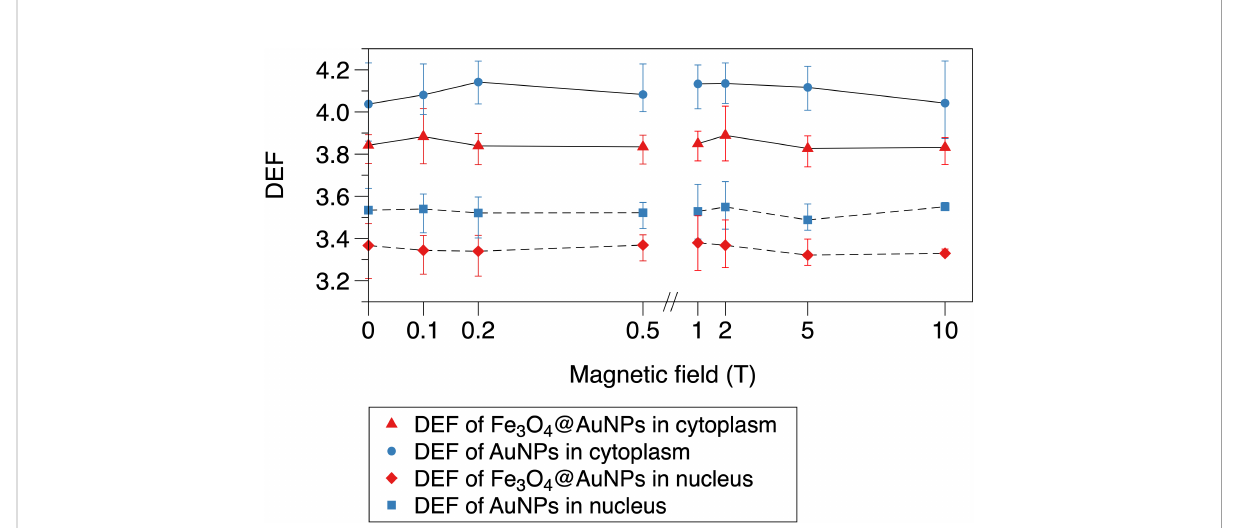
FIGURE 9 Relationship between magnetic fi eld and DEF of Fe 3 O 4 @AuNPs and AuNPs in cytoplasm and nucleus.